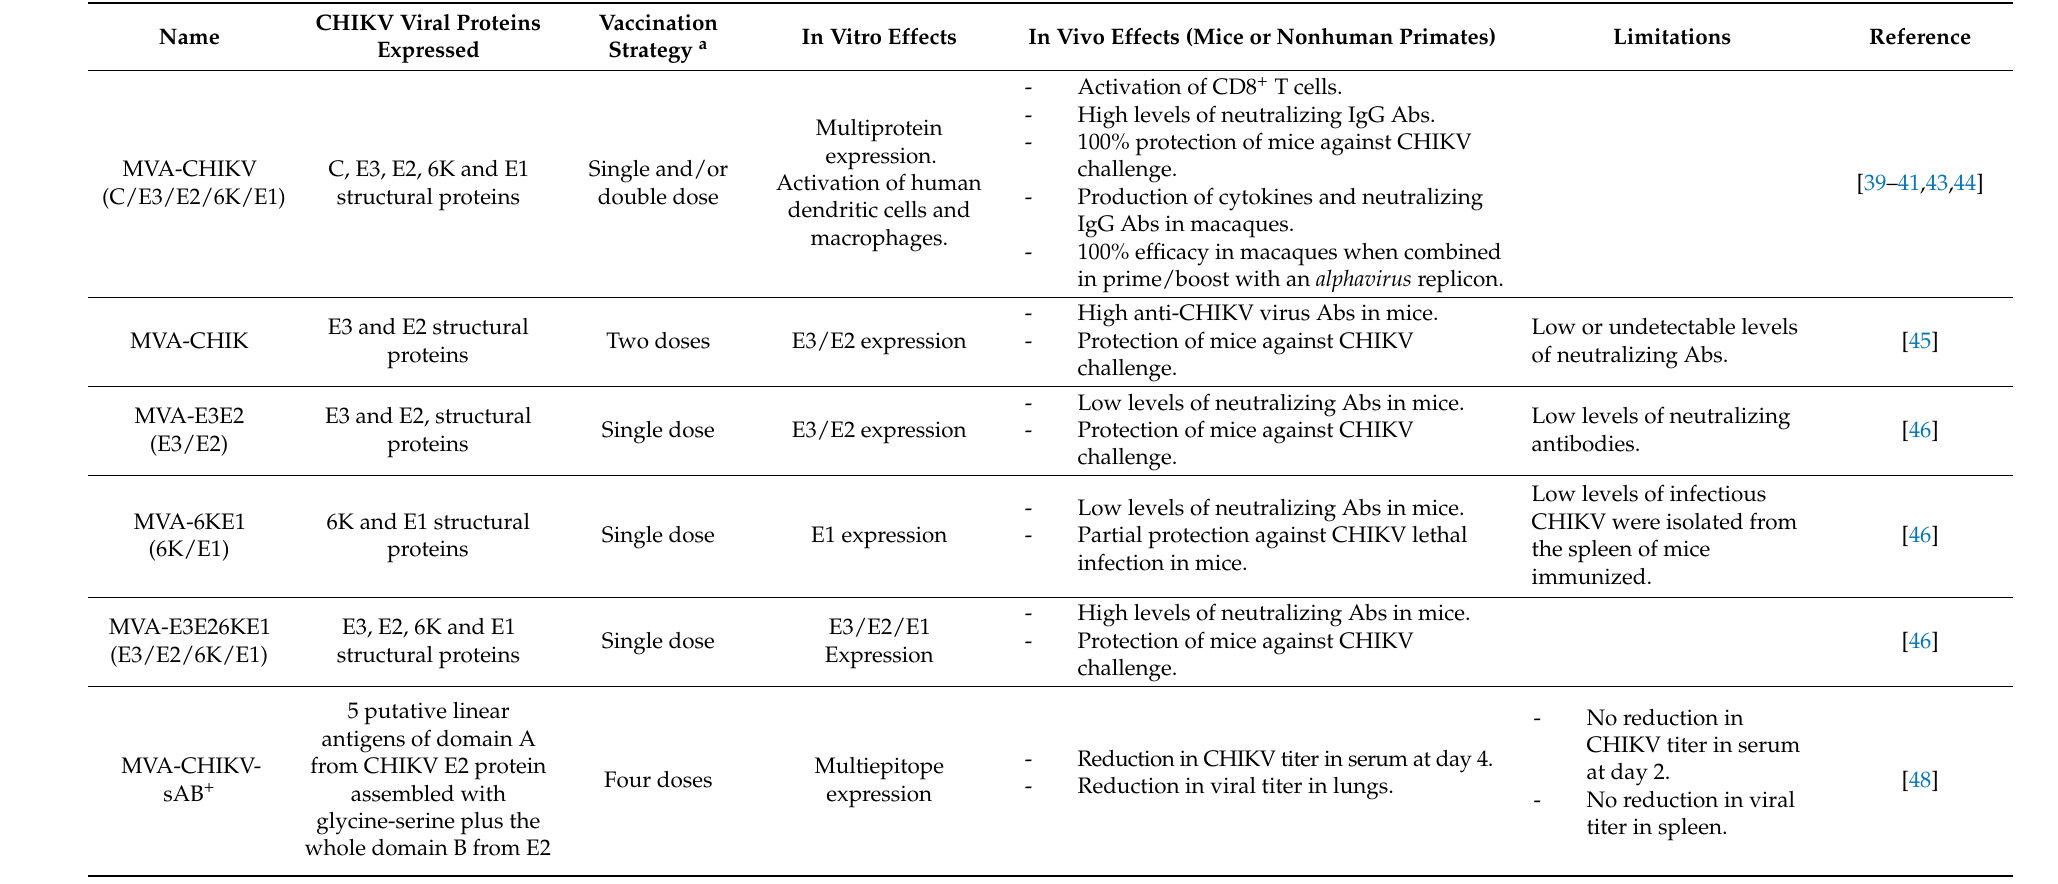
Table 1. Summary of recombinant MVA vaccine candidates against